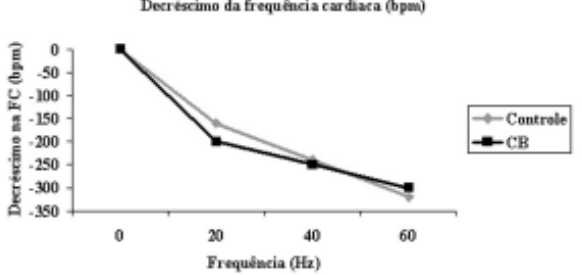
Fig. 1 – Freqüência cardíaca de repouso e resposta bradicárdica à estimulação elétrica vagal direita (5V, 2ms, 1-128Hz) (n=10, NS).